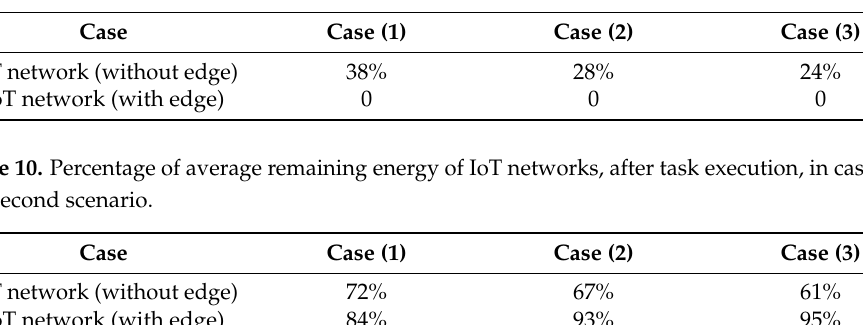
Table 9. Percentage of blocked tasks of IoT networks in case (II) of the second scenario.